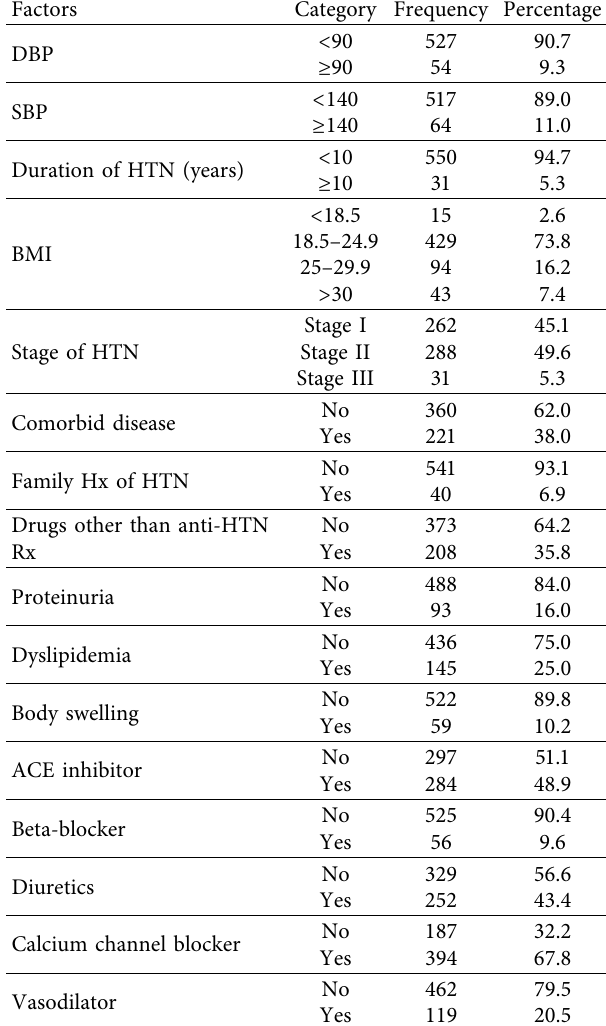
Table 3: Clinical factors of hypertensive patients attending at the chronic follow-up clinic at Northwest Ethiopia referral hospitals. Factors